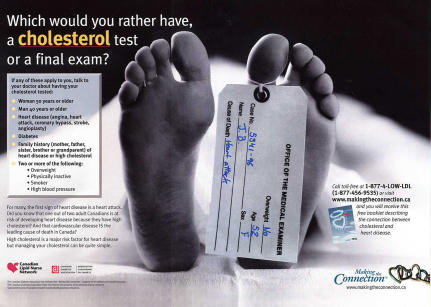
Disease-Awareness Campaign Sponsored by Pfizer, the Manufacturer of Lipitor(Image copyright: Pfizer Canada Inc./Making the Connection. All rights reserved.)